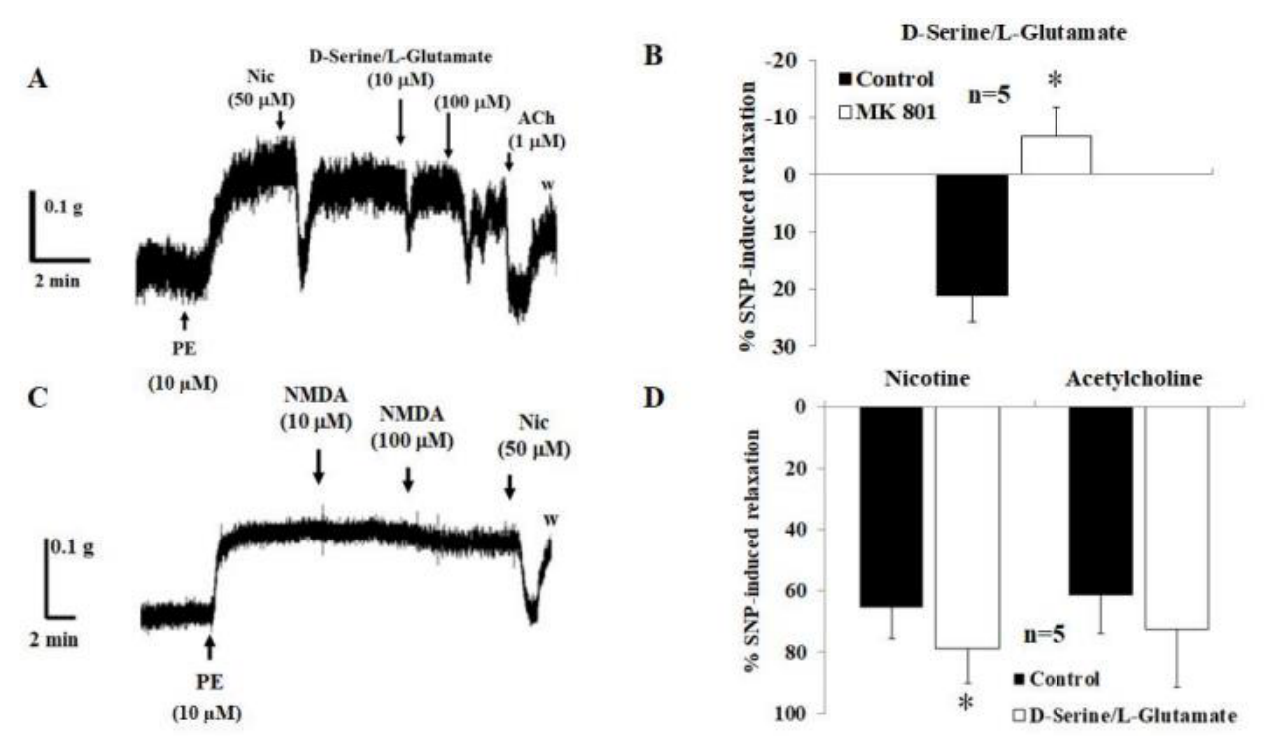
Figure 2. Corpus cavernosum relaxation induced by D-serine/L-glutamate. The representative tracing in ( A ) shows that corpus cavernosum (CC) strips are precontracted by phenylephrine (PE, 10 μM). Relaxation response induced by nicotine (Nic), D-serine/L-glutamate (10 and 100 μM), and acetylcholine (ACh, 1 μM). The D-serine/L-glutamate (100 μM)-induced relaxation was inhibited by MK-801 (10 μM, n = 5, p < 0.05 ( B )). The representative tracing in ( C ) shows that CC relaxation was not induced by N -methyl-D-aspartate (NMDA, 10 and 100 μM). Nicotine-induced relaxation was significantly enhanced by pretreatment with D-serine/L-glutamate (100 μM, n = 5), but acetylcho- line-induced relaxation was not enhanced by pretreatment with D-serine/L-glutamate ( D ). The drug-induced CC relaxation was estimated as the percentage of sodium nitroprusside (SNP, 0.1 mM)-induced maximum relaxation. n , number of experiments. Values are means ± SD. Asterisks